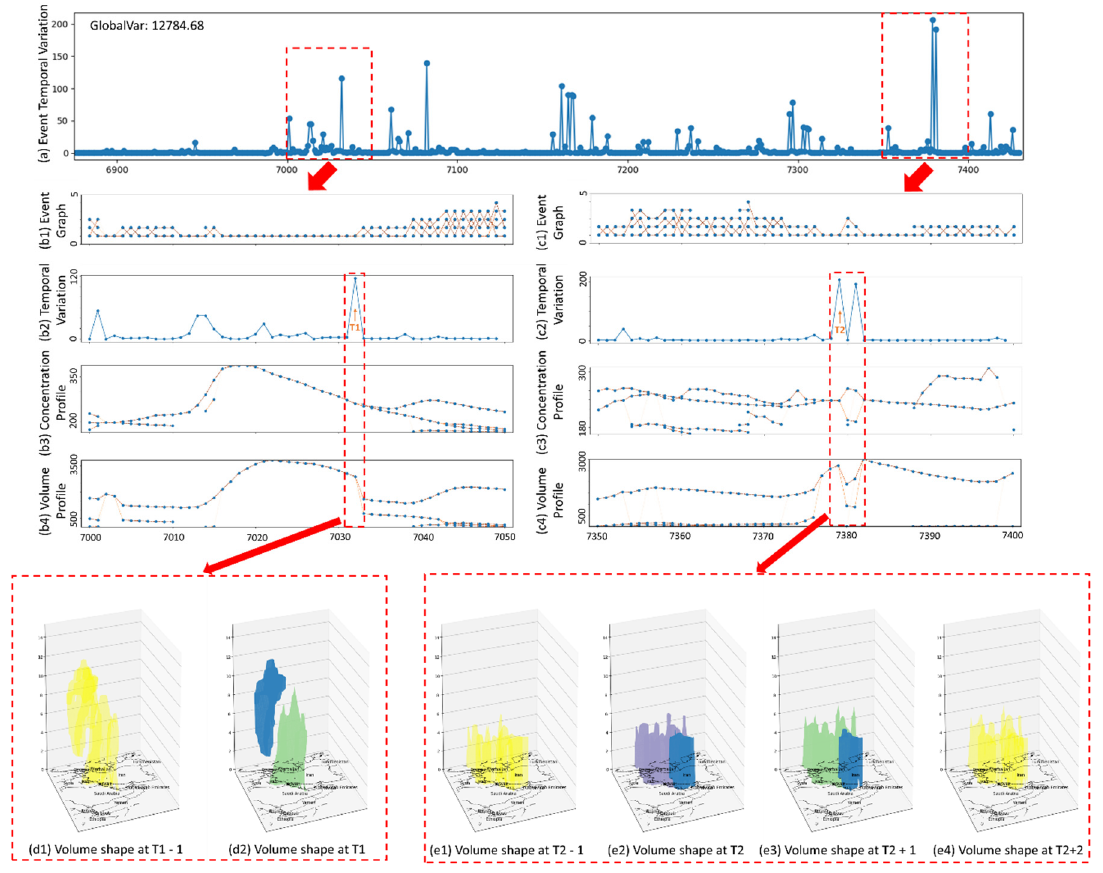
Figure 10. Event graph and temporal variation of the September 2014 dust event marching across Iraq and Iran. Figures d1, d2, e1–e4 highlight the volume and shape changes of the dust event and omit the event trajectory for the purpose of decluttered visualization.